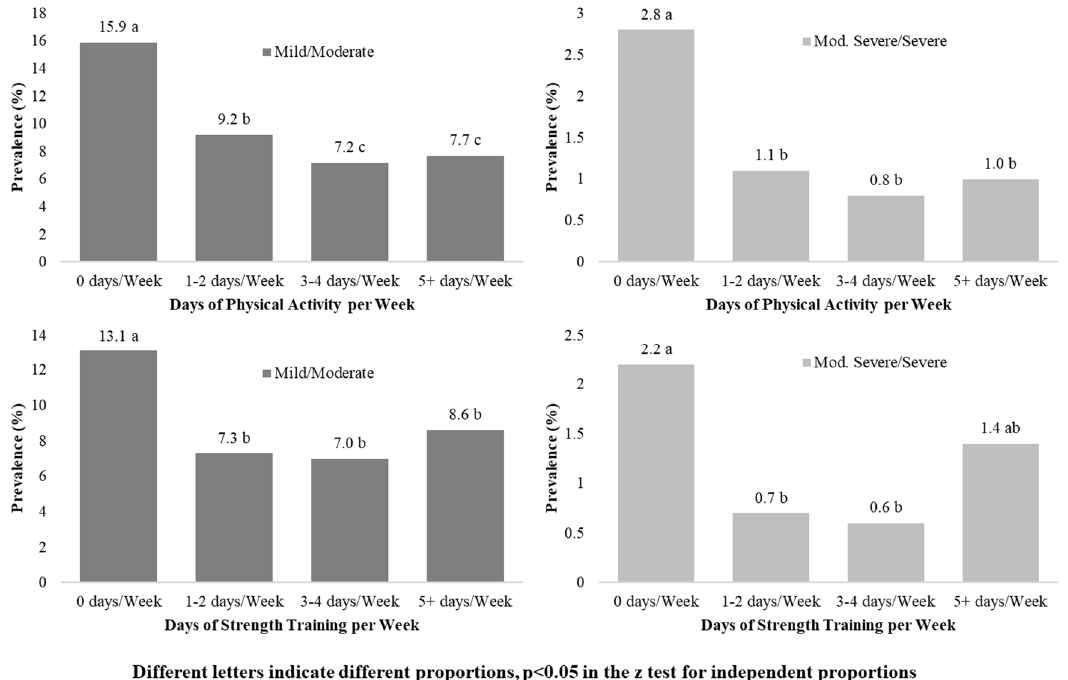
Figure 2. PA, strength training and prevalence of depressive symptoms in the general population. Dependency relationships were found between PA frequency and depressive symp- toms, in the general population and by sexes too ( p < 0.001). For the general population, the prevalence of major depression was lower in the active groups than in the inactive population: 5.0% (never), 1.7% (occasionally), 1.1% (several times a month) and 1.0% (sev- eral times a week); something similar to what was found in the prevalence of other forms of depression (Figure 3). The same dependency relationships were found in both sexes ( p < 0.001) (Table 3).